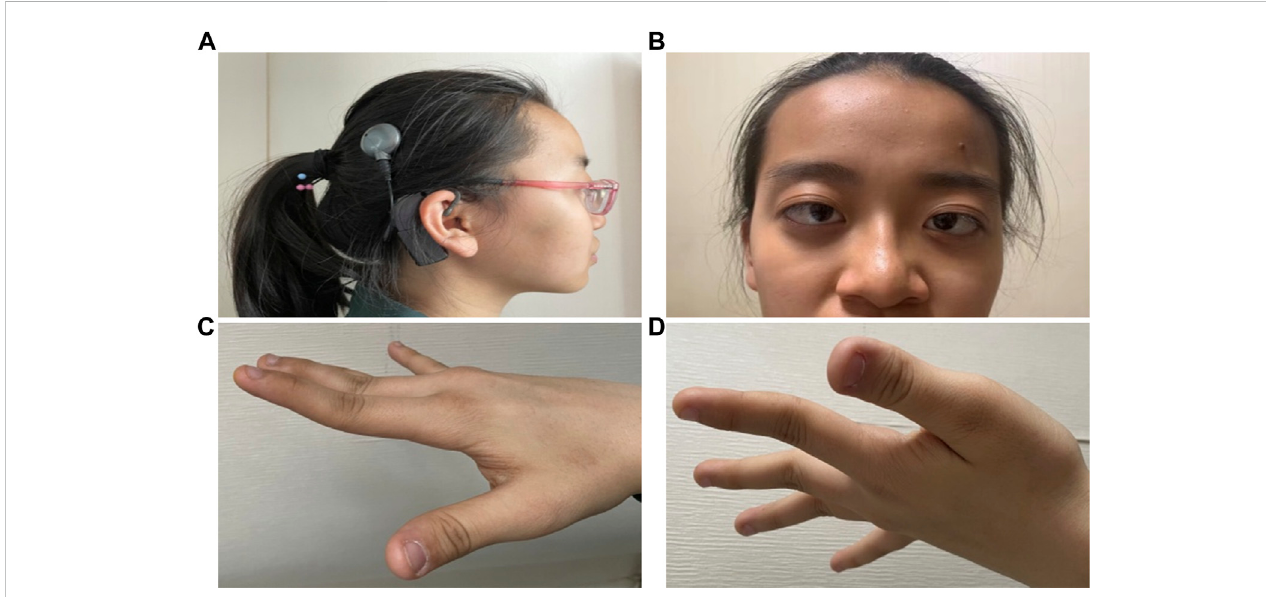
FIGURE 1 External photographs of DBS patient with early-onset high myopia. Patient is characterized by (A) Carrying hearing-aid as well as cochlear implant. (B) Ocular hypertelorism, exophthalmos, broad and high forehead, receding hairline, depressed nasal bridge, short nose with broad tip, and esotropia. (C, D) Hypermobility of the hand